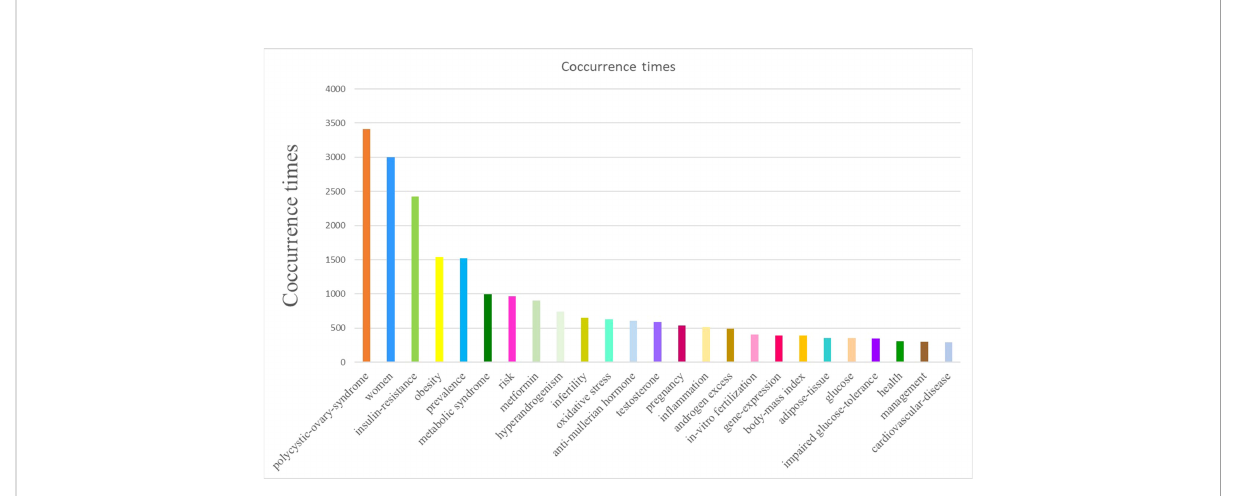
FIGURE 12 The top 25 keywords with the most frequent occurrences.